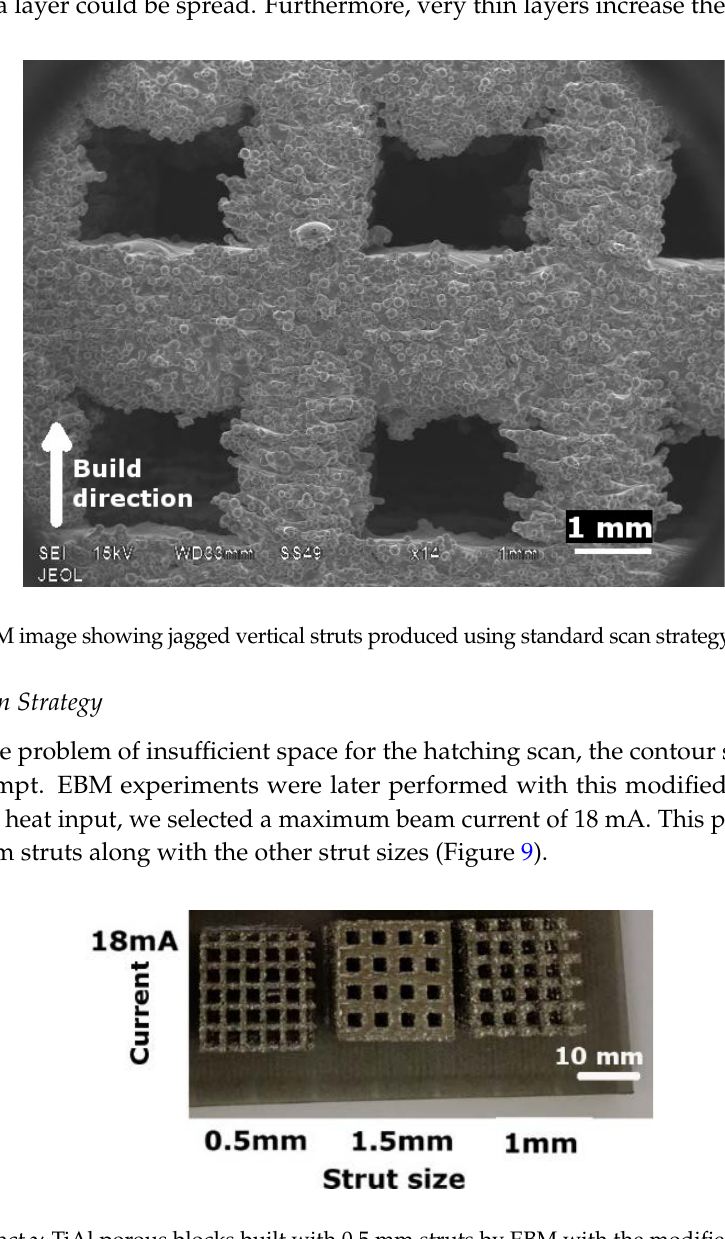
Figure 7. Macro image of 1.5 mm horizontal struts produced using standard scan strategy (cross- section along XY direction).